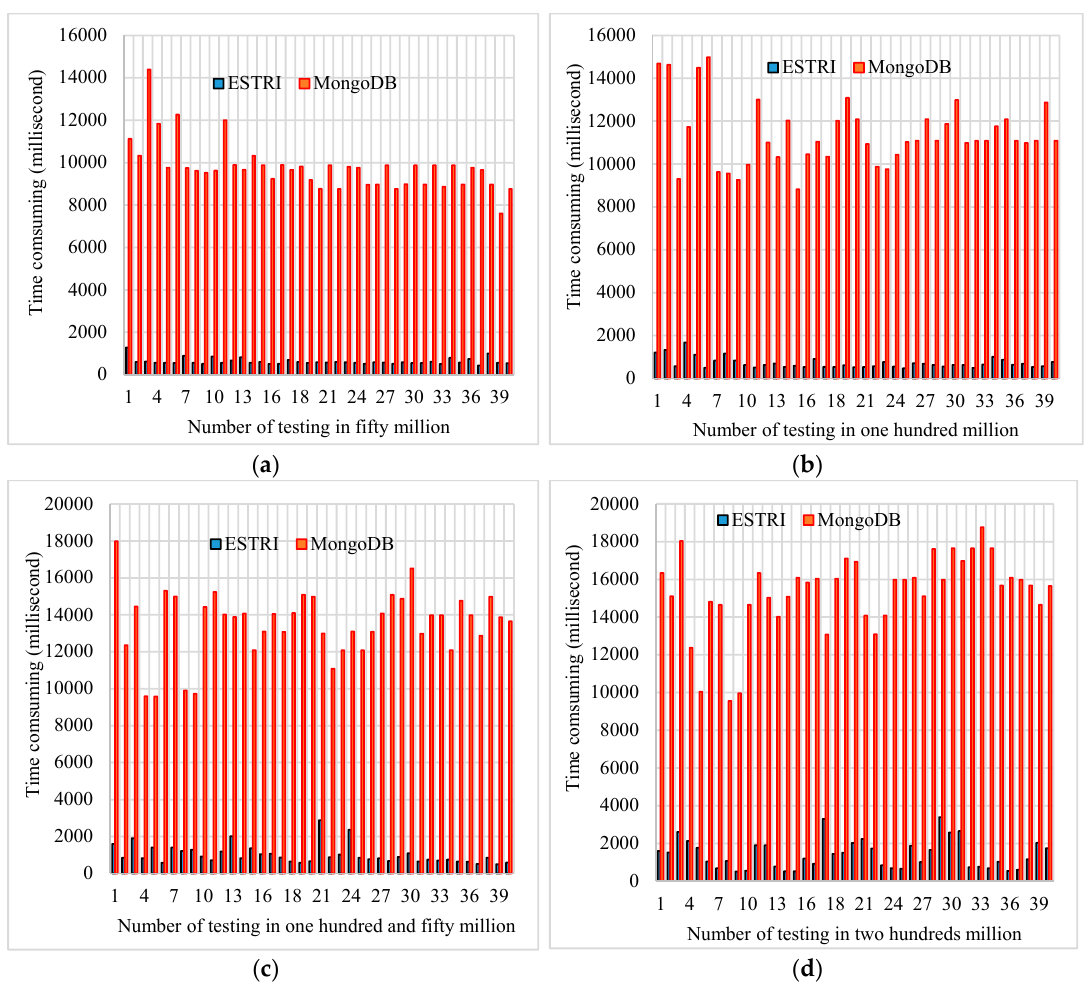
Figure 9. Time consumption comparisons between ESTRI (black color) and MongoDB (red color) for different amounts of data: ( a ) fifty million data; ( b ) one hundred million data; ( c ) one hundred and fifty million data; and ( d ) two hundred million data.